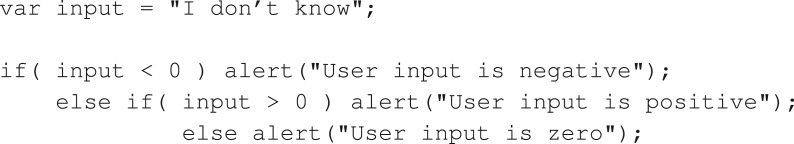
A user might enter the data ‘I don’t know’ into a numeric field on a web site programmed in JavaScript. JavaScript is a very popular web language but it is not type-checked. JavaScript will happily compare the non-numeric string the user has entered with the number zero, without any errors at compile time or run time. Since what the user entered is neither negative nor positive, the program will deduce it must be zero, which of course it is not. The error may then propagate through the program and cause further problems. In a type-checked language, strings and numbers are not comparable and a program like this would not compile, so the programmer would have to develop a ‘type correct’ program before it could be used.